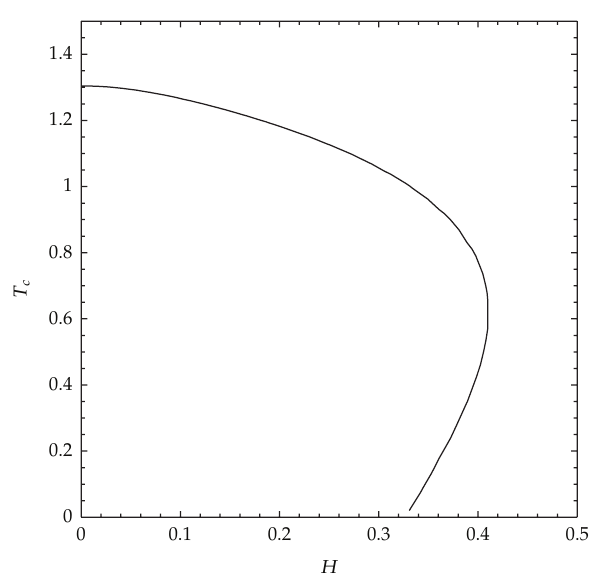
Figure 1: The phase diagram of T c against the magnetic field H . The condensed phase (cid:4) D 2 / (cid:7) 0 (cid:5) corresponds to the lower left part below the line. The critical temperature decreases as the magnetic field grow up to the critical value H c .